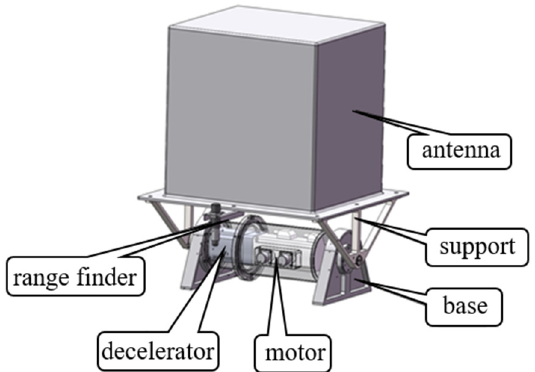
Figure 2. To ensure that the electromagnetic wave signal is incident vertically into the surface, an antenna deflection mechanism is provided on the top of the manipulator.